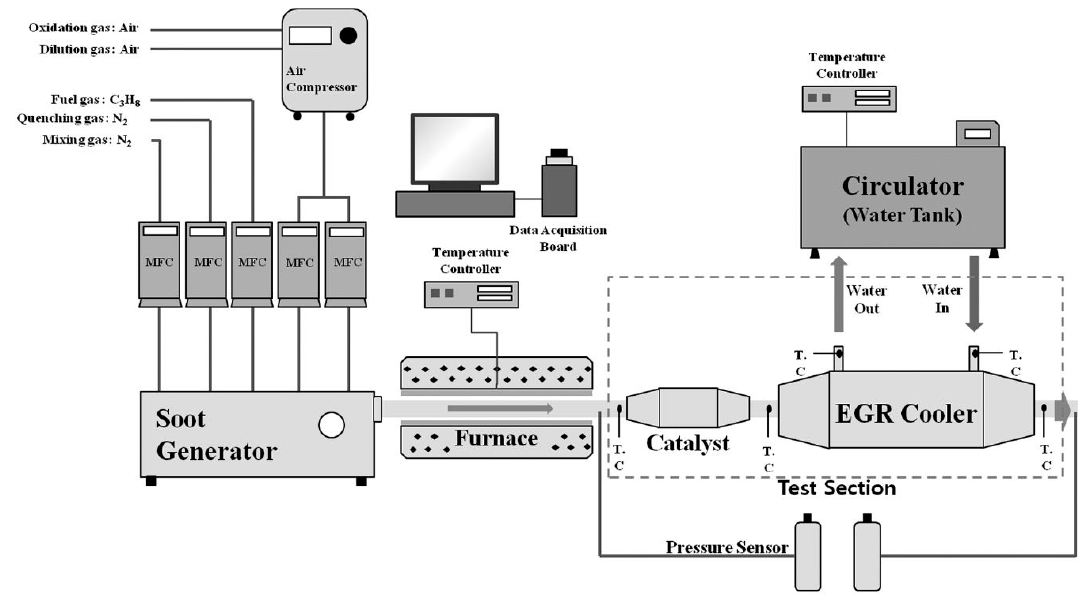
Figure 1. Schematic diagram of laboratory experimental system.